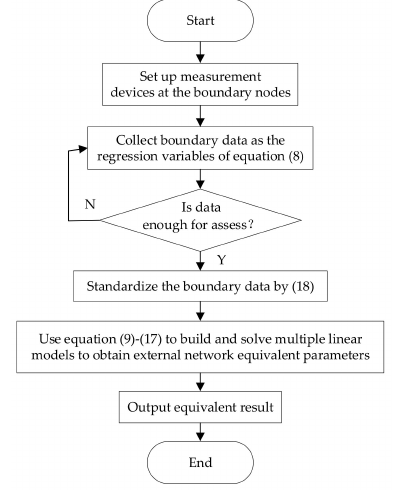
Figure 3. External network equivalent